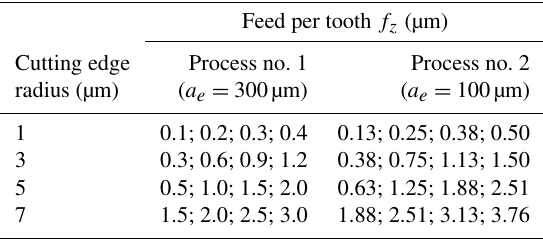
Table 3. Parameter selection for the peripheral cutting edge.